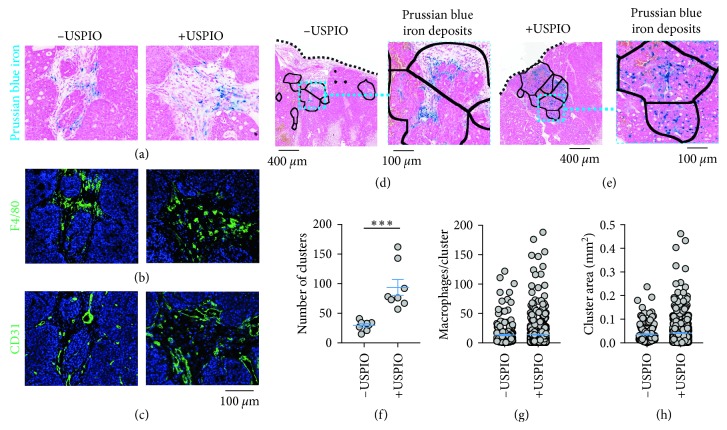
Spatial quantification of endogenous and contrast-enhanced macrophage deposits by iron histology. Paraffin-embedded sections from control (−USPIO) and iron nanoparticle-injected (+USPIO) tumors. (a) Prussian blue iron staining, (b) F4/80 macrophage immunofluorescence, and (c) CD31 vascular immunofluorescence were performed in the same sections to demonstrate the colocalization of iron deposits with infiltrating macrophages in vascular areas of the tumor microenvironment. Histological fields from (d) control and (e) iron nanoparticle-injected mice showing deposits of Prussian blue iron+ macrophages localized in infiltrative border regions in discrete clusters. Black borders are regions of interest drawn automatically around deposits of cells according to iron status. Expansion shows iron+ macrophages in the deposit regions. (f) Number of iron deposits (clusters) per tumor cross section in control (−USPIO) and nanoparticle-injected (+USPIO) mice (mean ± SEM shown, n=8 tumors/group, ∗∗∗p < 0.001, two-tailed unpaired Student's t-test). (g) Number of iron+ macrophages per deposit, and (h) size of each of the deposits measured over the whole Paraffin-embedded tumor cross sections stained by Prussian blue (mean ± SEM shown, −USPIO n=235 total clusters/group, +USPIO n=748 total clusters/group, n.s. p > 0.05). Scale bar is shown for all images.